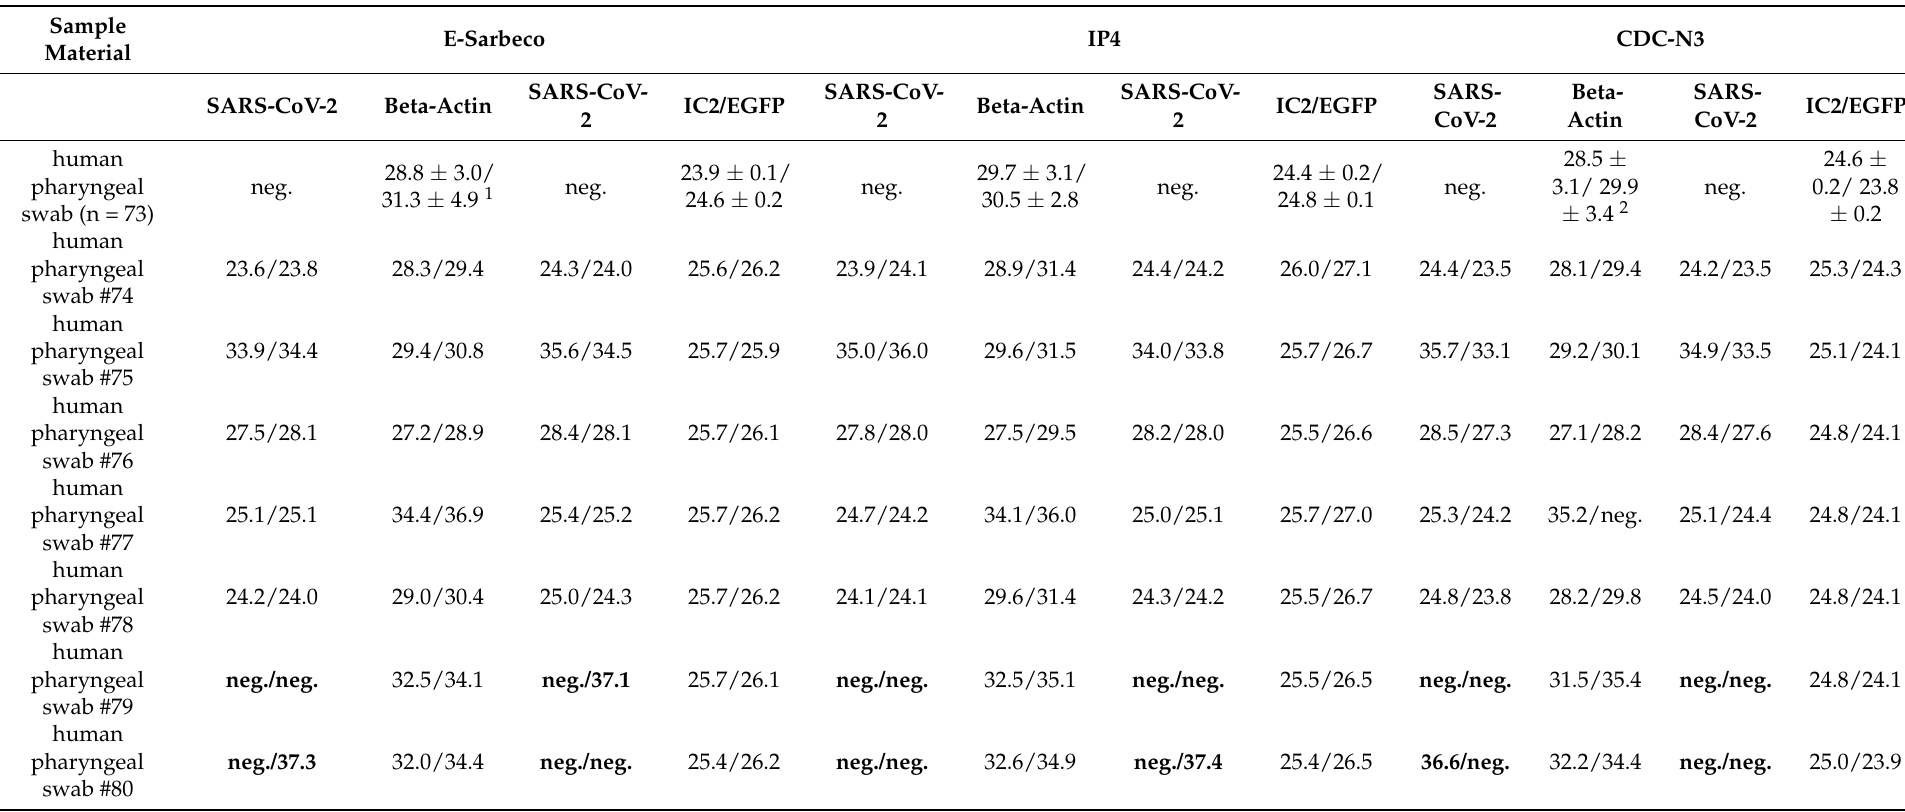
Table 2. Clinical performance of the SARS-CoV-2 real-time RT-PCRs that were optimized for a low total reaction volume. Seventy-three negative and 20 presumably SARS-CoV-2 positive human pharyngeal swabs were investigated using three different real-time RT-PCRs combined with an internal control based either on the housekeeping beta-actin gene or a heterologous control RNA (=IC2/EGFG). The first values were generated by combining the indicated real-time RT-PCR with the AgPath-ID One-Step RT-PCR Reagents kit, while the second values were produced with the qScript XLT One-Step RT-qPCR ToughMix kit. Disagreeing results are indicated in bold. neg.—negative, 1 68 out of 73 samples tested positive in the internal control assay, 2 70 out of 73 samples tested positive in the internal control